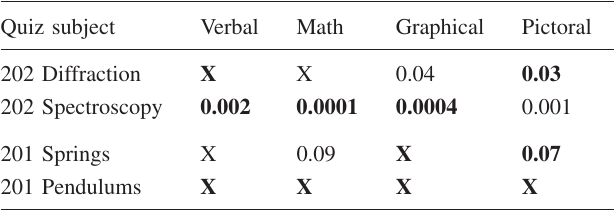
TABLE I. Statistical significance of the quiz performance dif- ferences between the format choice and control groups in the tradi- tional 202 and reform 201 sections. Numbers are p values using a two-tailed binomial proportion test. X denotes a p value of greater than 0.10. Bold indicates that the choice group had higher perfor- mance than the control group.